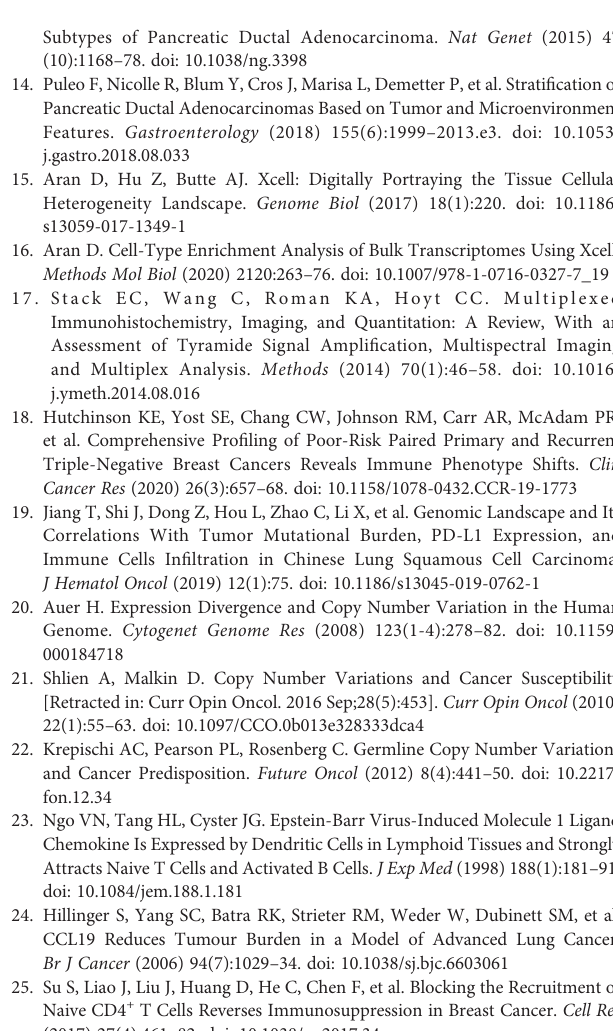
Supplementary Figure S3 | Interaction between chemotherapy on risk-score in TCGA PDAC dataset. (A – C) OS in the patients with Chemotherapy vs . without Chemotherapy in all-patient, high risk-score group and low risk-score group from TCGA PDAC dataset depicted by KM plots respectively. (D) Violin plot for analysis risk-score value between patients with Chemotherapy and without Chemotherapy group in TCGA PDAC dataset. (E – F) OS in high risk-score vs . low risk-score patients with chemotherapy or without chemotherapy from TCGA PDAC dataset depicted by KM plots, respectively. (G – H) ROC curves to depict the accuracy of risk-score in identifying poor OS of patients with chemotherapy or without chemotherapy in TCGAPDACdiscovery cohortfor 1-year and3-year, respectively. KM, Kaplan Meier survival analysis; Chemotherapy, the patients with chemotherapy, no Chemotherapy, the patients without chemotherapy; ns, no statistical signi fi cance.